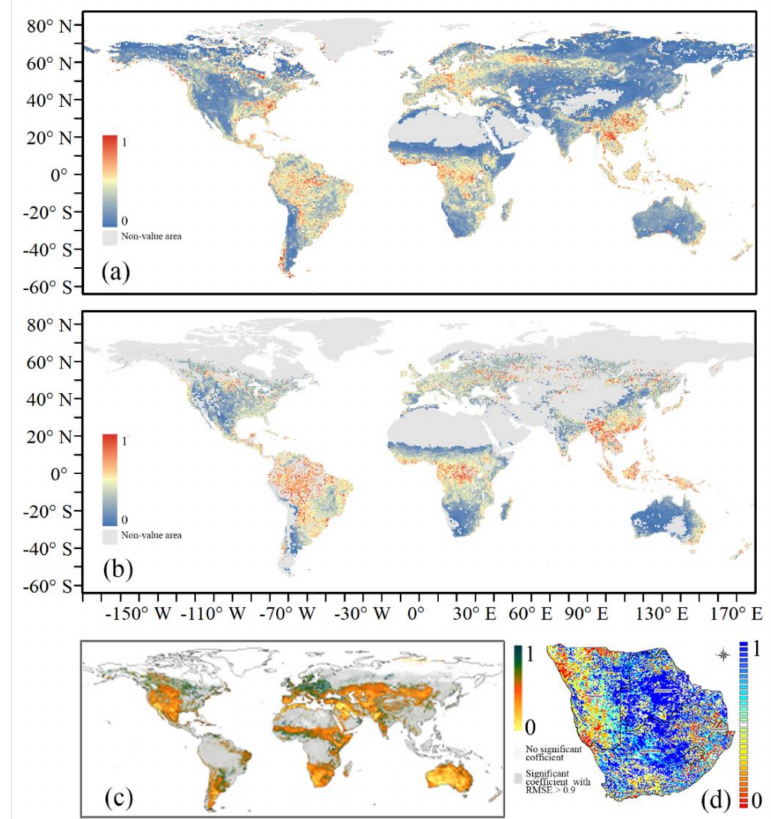
Figure 5. Distribution of terrestrial ecosystem resilience. ( a ) terrestrial resilience from GLASS LAI, ( b ) terrestrial resilience from GIMMS AVHRR LAI 3g, ( c ) global vegetation resilience from Keersmaecker et al., and ( d ) Southern Africa ecosystem resilience from Harris et